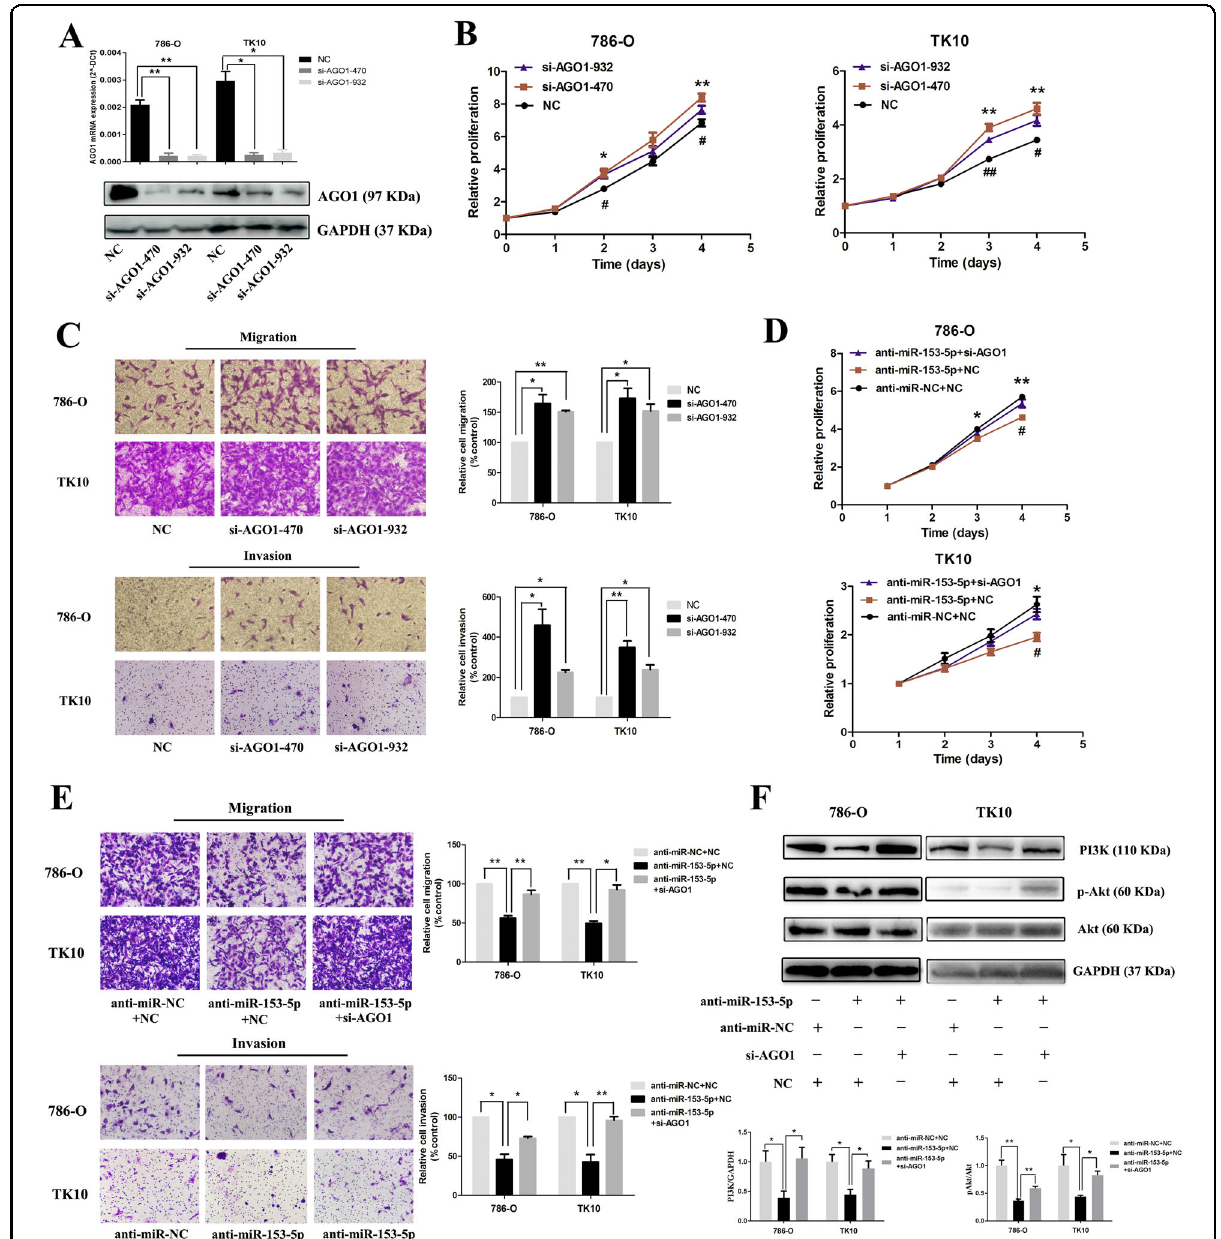
Fig. 6 The role of miR-153-5p on tumor progression is mediated via the downregulation of AGO1. A The expression level of mRNA and protein of AGO1 in 786-O and TK10 after transfection with siRNA of AGO1. B The proliferation rate of ccRCC after AGO1 knockdown. C Effect of AGO1 knockdown on migration and invasion. The proliferation ( D ) and metastasis ( E ) of ccRCC after co-transfection with miR-153-5p inhibitor or NC inhibitor with either AGO1 siRNA or NC. F The alterations of the PI3K/Akt pathway after co-transfection with miR-153-5p inhibitor or NC inhibitor with either AGO1 siRNA or NC. All experiments were conducted at least three independent times and all the values were presented as mean ± SEM. * P < 0.05, ** P < 0.01 ( B vs. NC; D vs. anti-miR-153 + NC); # P < 0.05, ## P < 0.01; B vs. si-AGO1-932; D vs. anti-miR-153-5p +